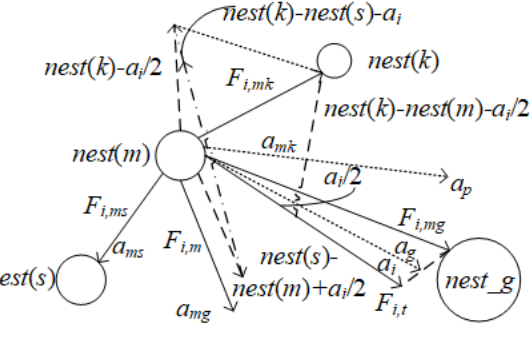
Fig. 3. Mechanism of acceleration by